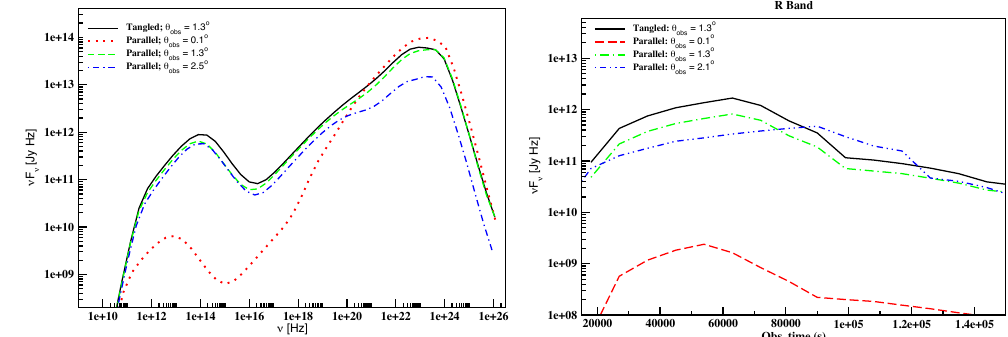
Figure 4. ( Left ): Comparison of time-averaged SEDs of the generic blazar generated using a magnetic field aligned parallel to the jet axis with that obtained using a tangled field (base set). Within the parallel goemetry, the three SEDs are generated by varying the viewing angle; ( Right ): Comparison of pulse profiles of an optical synchrotron photon in the R band, for the same cases, for various viewing